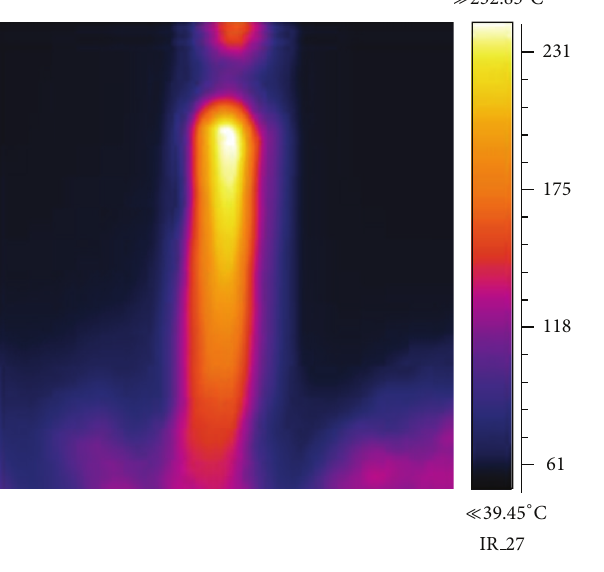
Figure 8: Thermal image of the ROI at 𝑡 = 145 sec.